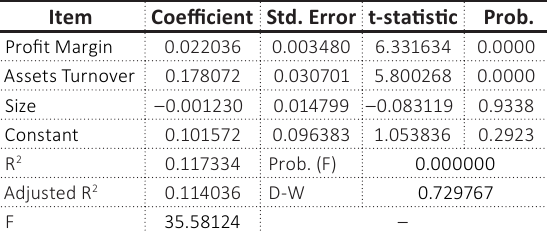
Table 8. Coefficients for the second